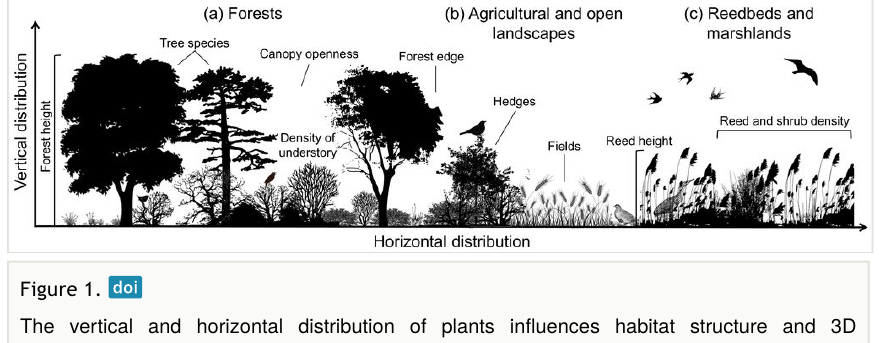
The vertical and horizontal distribution of plants in fl uences habitat structure and 3D characteristics of vegetation for animals. Illustrated are examples for (a) forests, (b) agricultural and open landscapes, and (c) reedbeds and marshlands. The height, openness and density of vegetation as well as speci fi c habitat features (e.g. tree species, hedges etc.) are key aspects of animal habitat and space